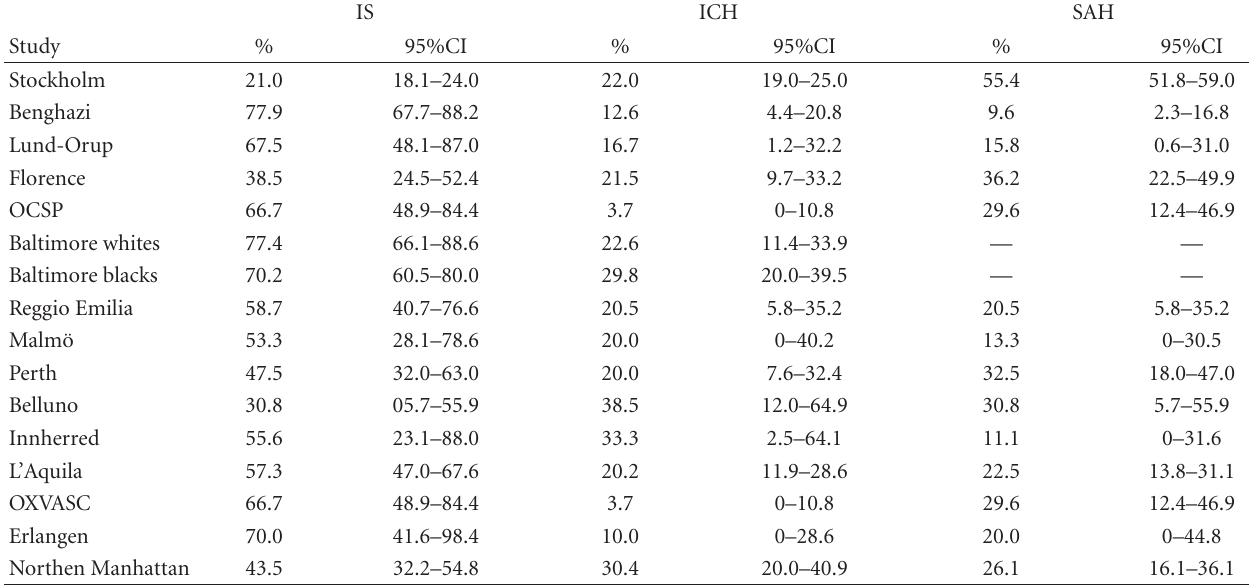
Table 3: Proportion of di ff erent stroke types in the included